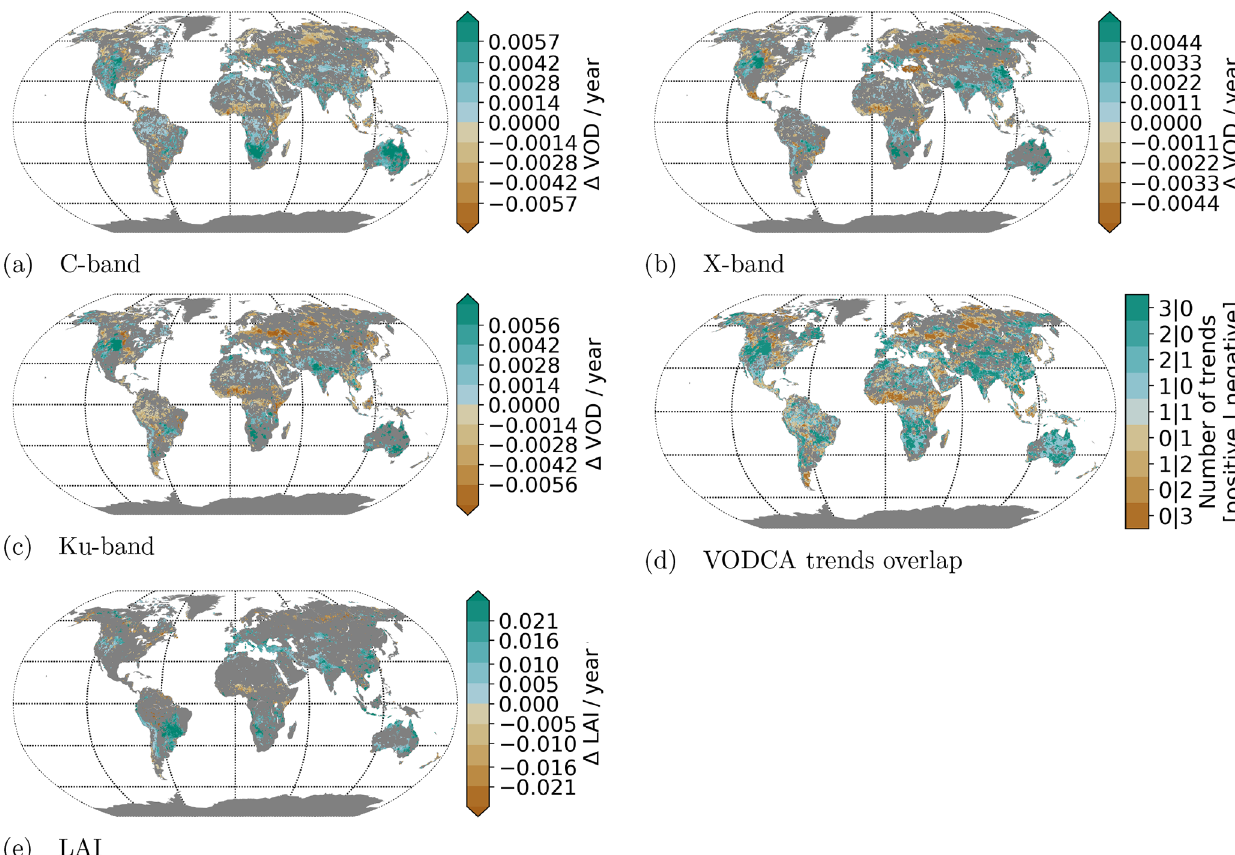
Figure 13. Trends of various bands between 2002 and 2017 of VOD (a–c) and LAI (e) . Non-significant trends are not displayed; the trends are calculated by Theil–Sen regression using yearly mean values. Panel (d) shows trend classes based on the number of VOD bands exhibiting a positive | negative trend. For example, 2|1 indicates that two VOD bands show a significant positive trend, while one band shows a significant negative trend. Their order and colour are indicative of the likelihood of the trend.